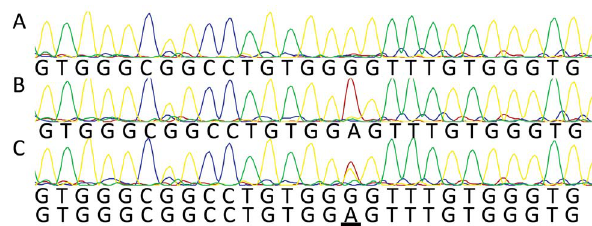
Figure 6. Allelic drop-out in PCR with templates methylated in vitro . PCR products (primers MESTPF1/ MESTPR6) were generated from genomic DNA homozygous for either the ATA or GCG haplotypes. Methylated and unmethylated forms of these amplicons were diluted and mixed, subjected to PCR, and then genotyped by Sanger sequencing. All three SNPs showed the same pattern, but results for only SNP rs75098511 are illustrated: (A) methylated ATA vs. unmethylated GCG showing apparent GCG homozygosity; (B) methylated GCG vs. unmethylated ATA showing apparent ATA homozygosity; (C) unmethylated ATA vs. unmethylated GCG showing apparent